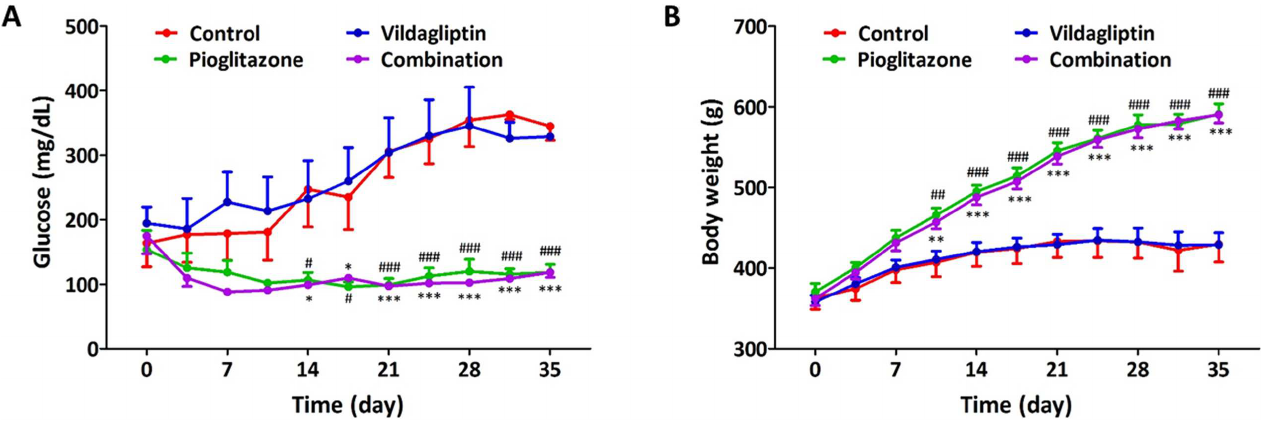
Fig 1. Changes in blood glucose level and body weight during the treatment in ZDF rats. (A) Changein blood glucoselevel duringthe treatment with control, vildagliptin(10 mg/kg/day), pioglitazone (30 mg/kg/day), and combination (vidalgliptin10 mg/kg/day and pioglitazone 30 mg/kg/day), (B) Changein body weight duringthe treatment with control, vildagliptin,pioglitazone, and combination. All data represented as Mean ± SD. * p < 0.05, ** p < 0.01, *** p < 0.001 (combination group) and # p < 0.05, ## p < 0.01, ### p < 0.001 (pioglitazonegroup) comparedwith control